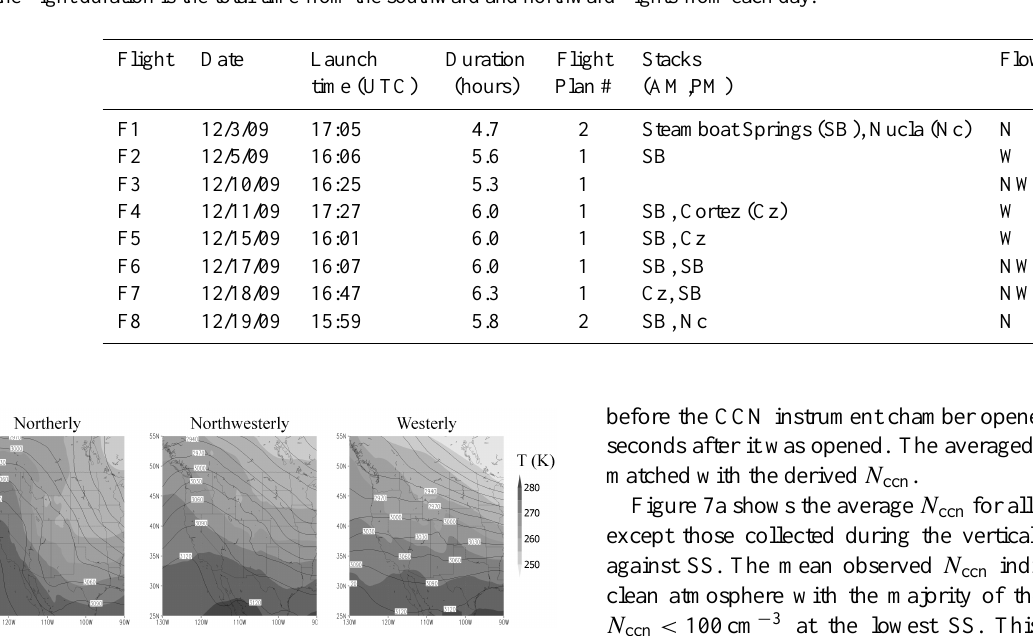
Table 2. Flight dates and information about the flight paths, flow regimes, and data observed for all King Air flights in December 2009. Note that the flight duration is the total time from the southward and northward flights from each day.